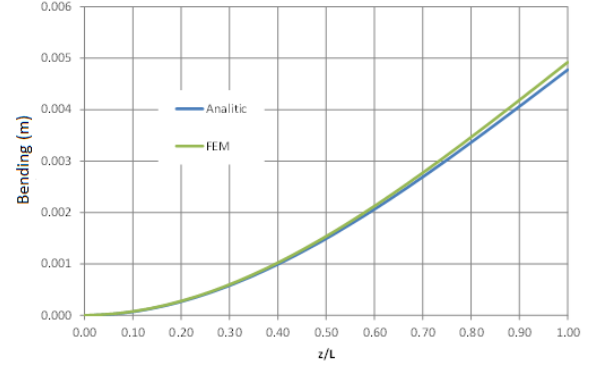
Fig. 9 Bending response - FEM vs. analytical